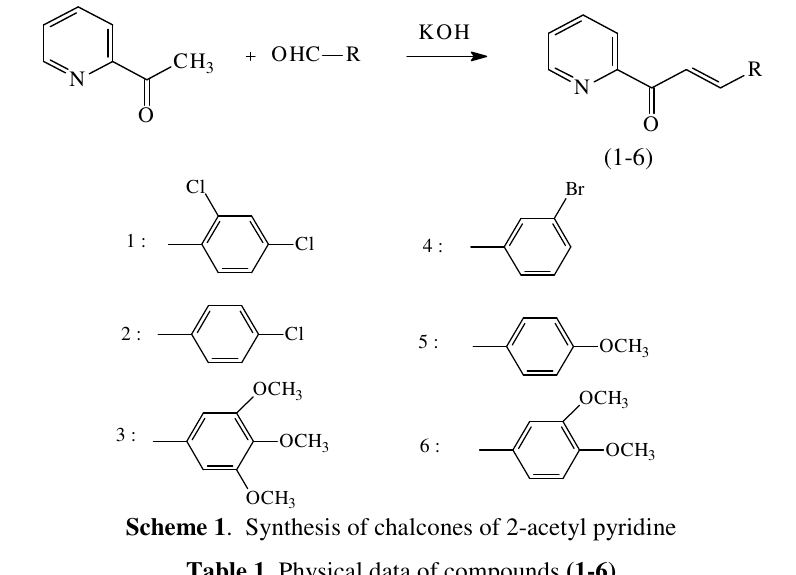
Table 1. Physical data of compounds (1-6) Elemental analyses,